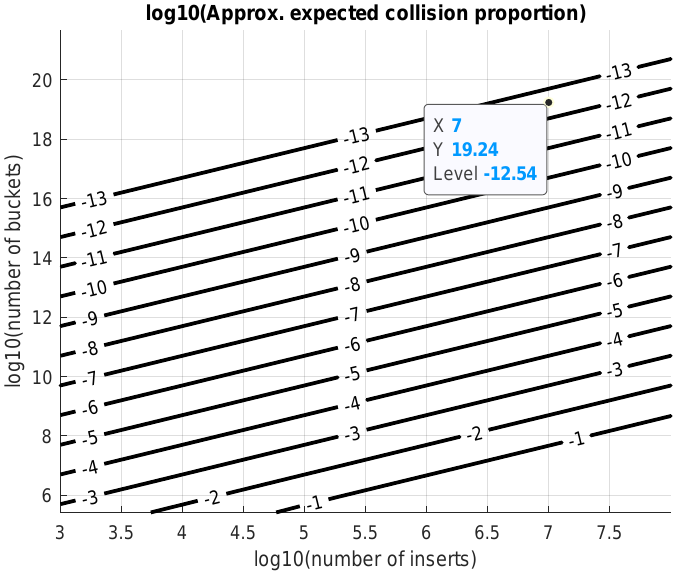
Figure 4. Level sets of the approximation (3) of the collision rate as a function of the number of inserts n and the number of buckets m